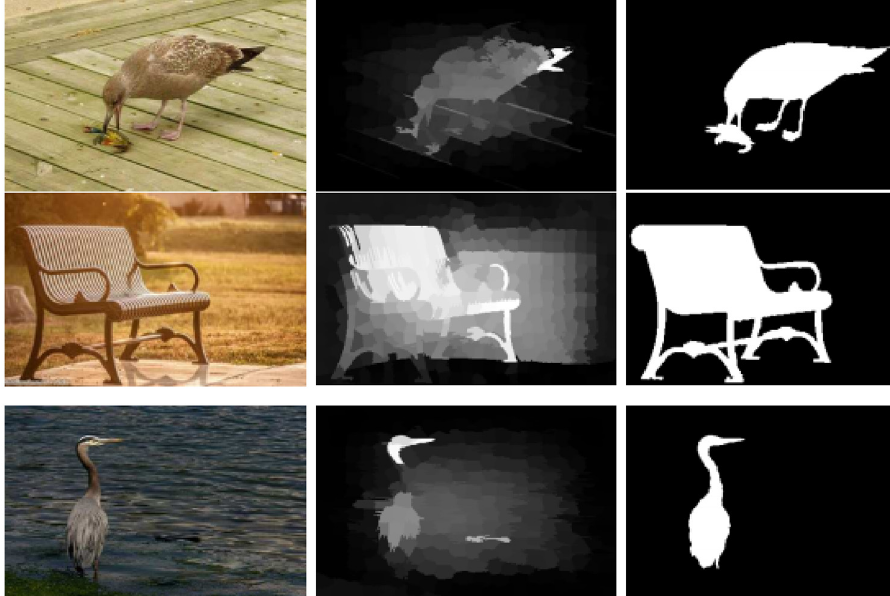
Fig 14. Some cases in which the designed method results are not satisfactory. The results are similar but not identical to the original images and is therefore for illustrative purposes only.